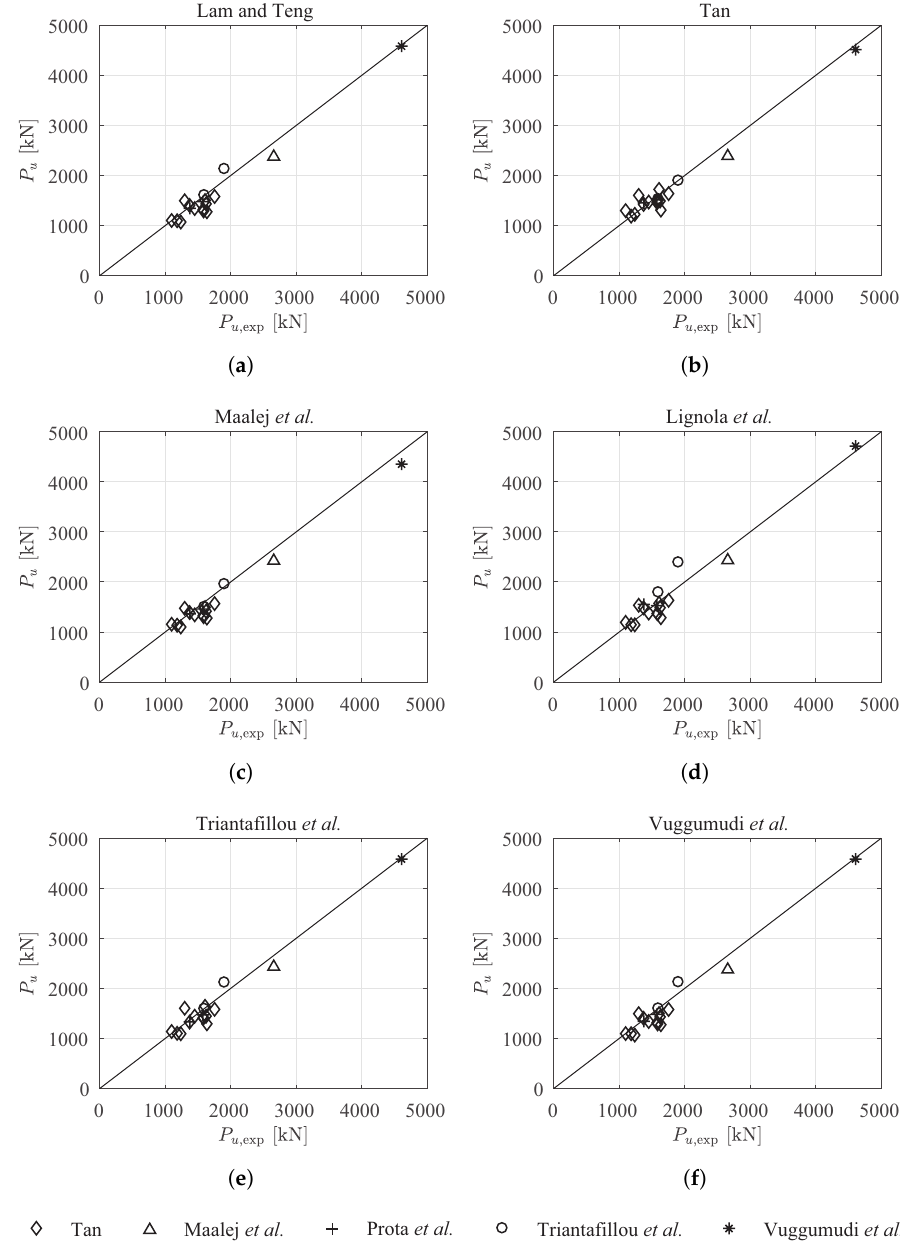
Figure 4. Performance of the analytical models in axial load capacity: scatter plot diagrams for the analytical model of ( a ) Lam and Teng [10]; ( b ) Tan [20]; ( c ) Maalej et al. [27]; ( d ) Lignola et al. [22]; ( e ) Triantafillou et al. [31]; ( f ) Vuggumudi et al. [32] (safe side down to straight